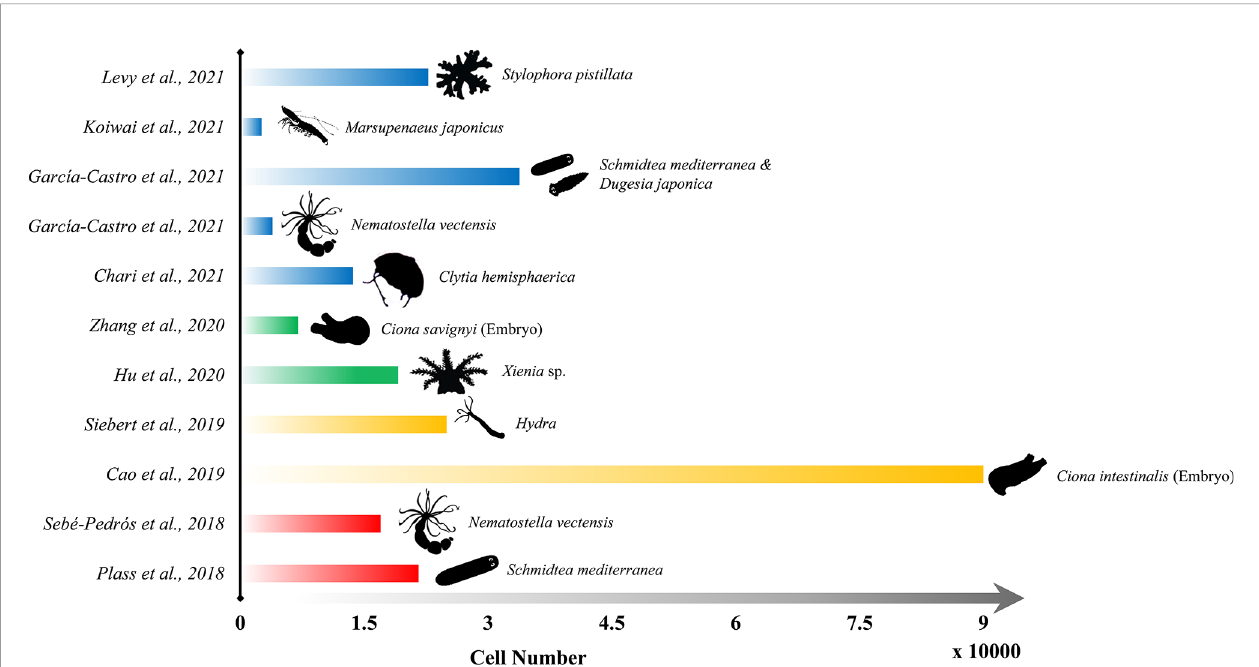
FIGURE 4 | Representative publications of the application of scRNA-seq on marine organisms since 2018. Length of each bar refers to the sequenced cell numbers, and the outline of each species are shown on the right end of the